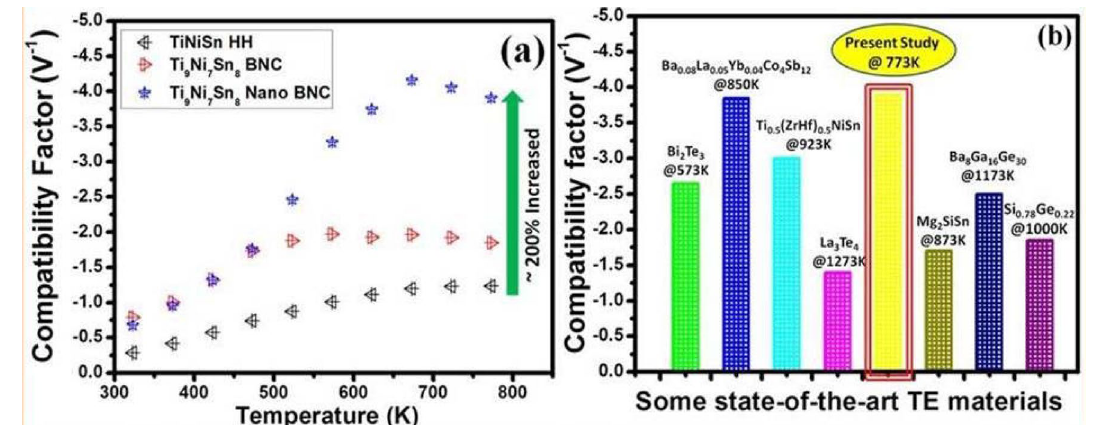
Fig. 8 a Temperature-dependent thermoelectric compatibility factor (S) for TiNiSn (HH), Ti 9 Ni 7 Sn 8 (BNC), and Ti 9 Ni 7 Sn 8 (Nano-BNC); b comparison of the compatibility factors of Ti 9 Ni 7 Sn 8 (Nano-BNC)